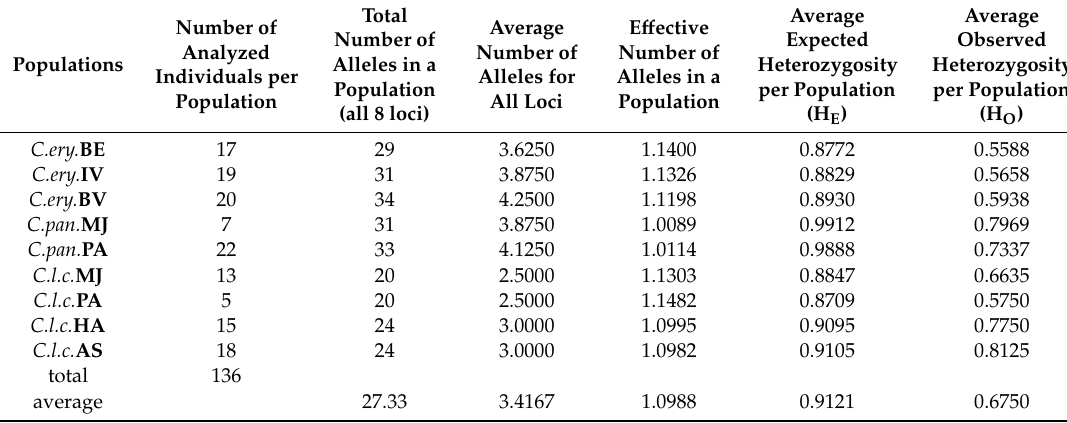
Table 1. Population genetics parameters obtained by eight genic microsatellite loci: the total, average and effective number of alleles in populations and the values of the observed (H O ) and expected heterozygosity (H E ) of the populations are presented.